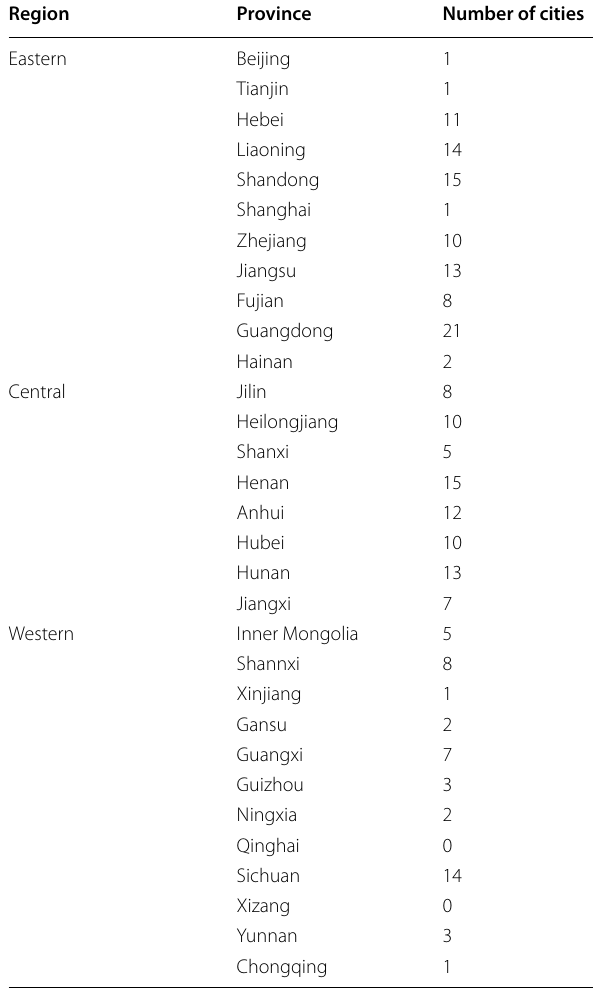
Table 1 Number of cities used by provinces in this study